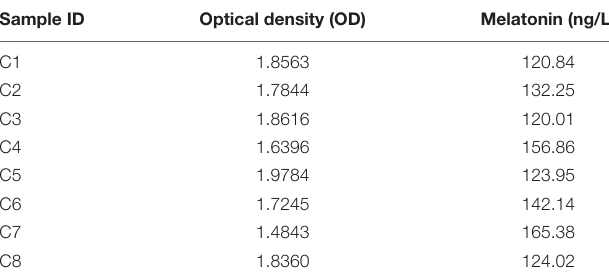
TABLE 1 | Concentrations of melatonin in the coelomic fluid of A. japonicus based on the method of ELISA test. Sample